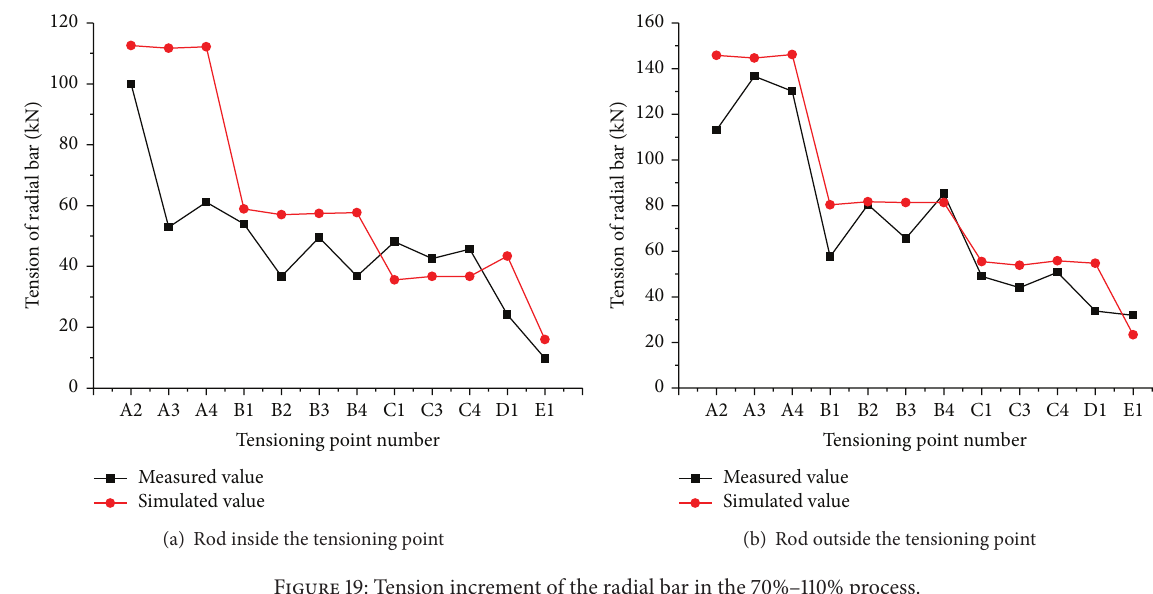
Figure 19: Tension increment of the radial bar in the 70%–110% process.